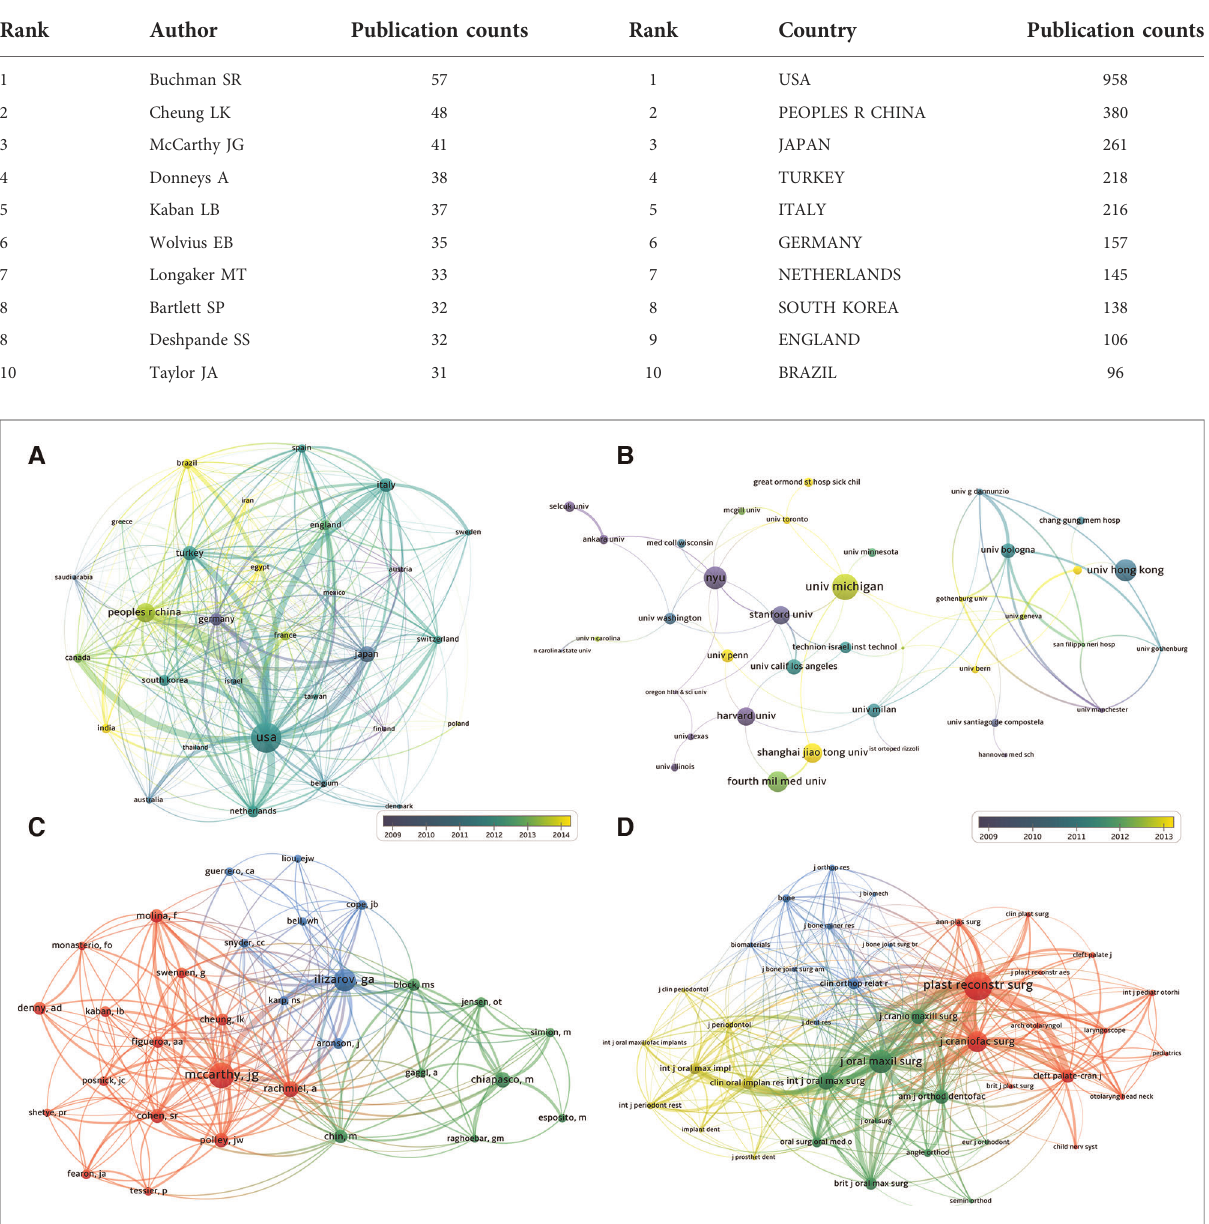
TABLE 1 The top 10 most productive authors and countries contributing to the research on craniomaxillofacial distraction osteogenesis from 2000 to 2021.